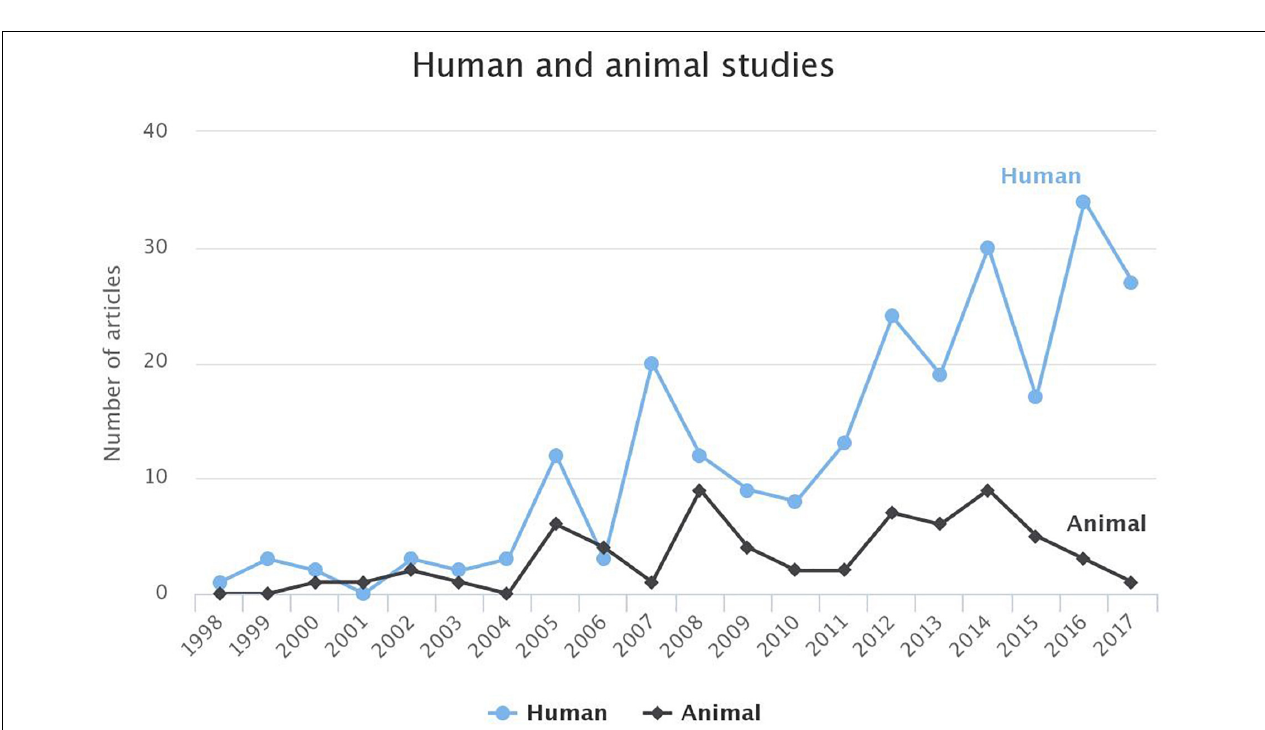
FIGURE 5 | Comparison of the studies based on human or animal models for AF for each year. For 2018, until 1st of March 2018, the studies targeting humans and animals were 3 and 0, respectively. To avoid any false perception those data have not been visualized.